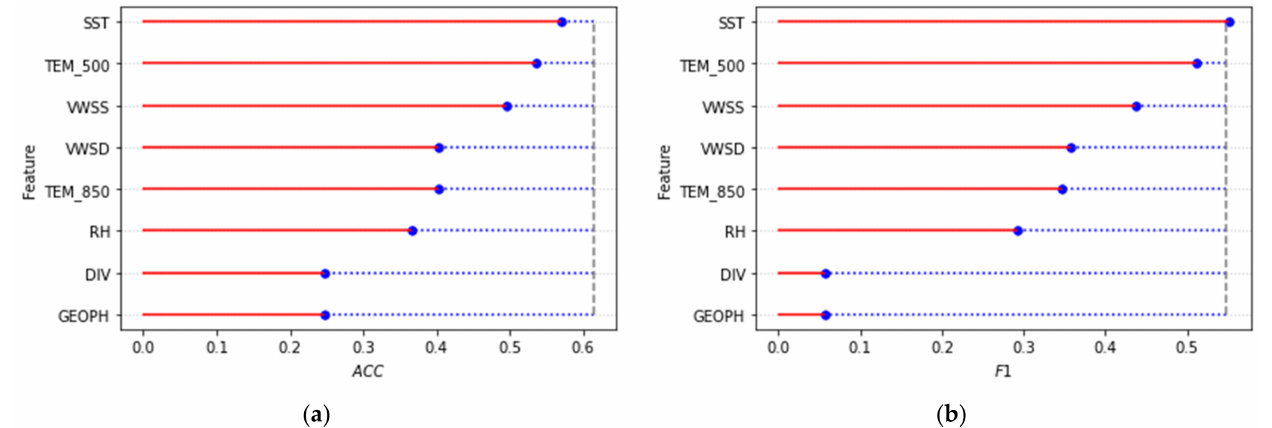
Figure 5. Performance comparison results of models stimulating TCI trained with certain predictors. ( a , b ) show the performance results in ACC and F1 , respectively. Red solid lines show the values of estimation metrics. Grey dashed lines show the performance of control models inputting all predictors. Blue dotted lines show the difference of performance between the control model and the experimental model.